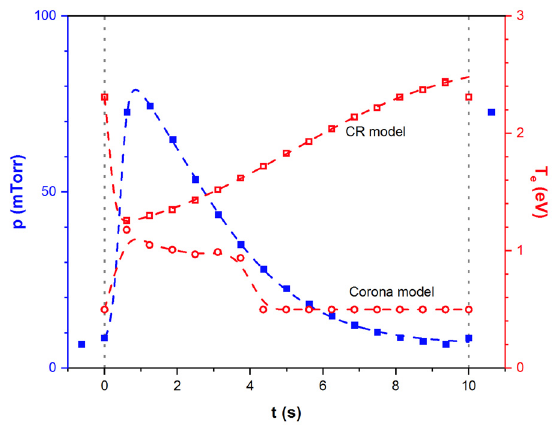
Figure 6. Comparison of the evolution of the electron temperature (red curves) and the pressure pulse (blue curve) on a normalized injection period for an injection frequency of 0.1 Hz. Electron temperatures are shown for both CR and Corona models.